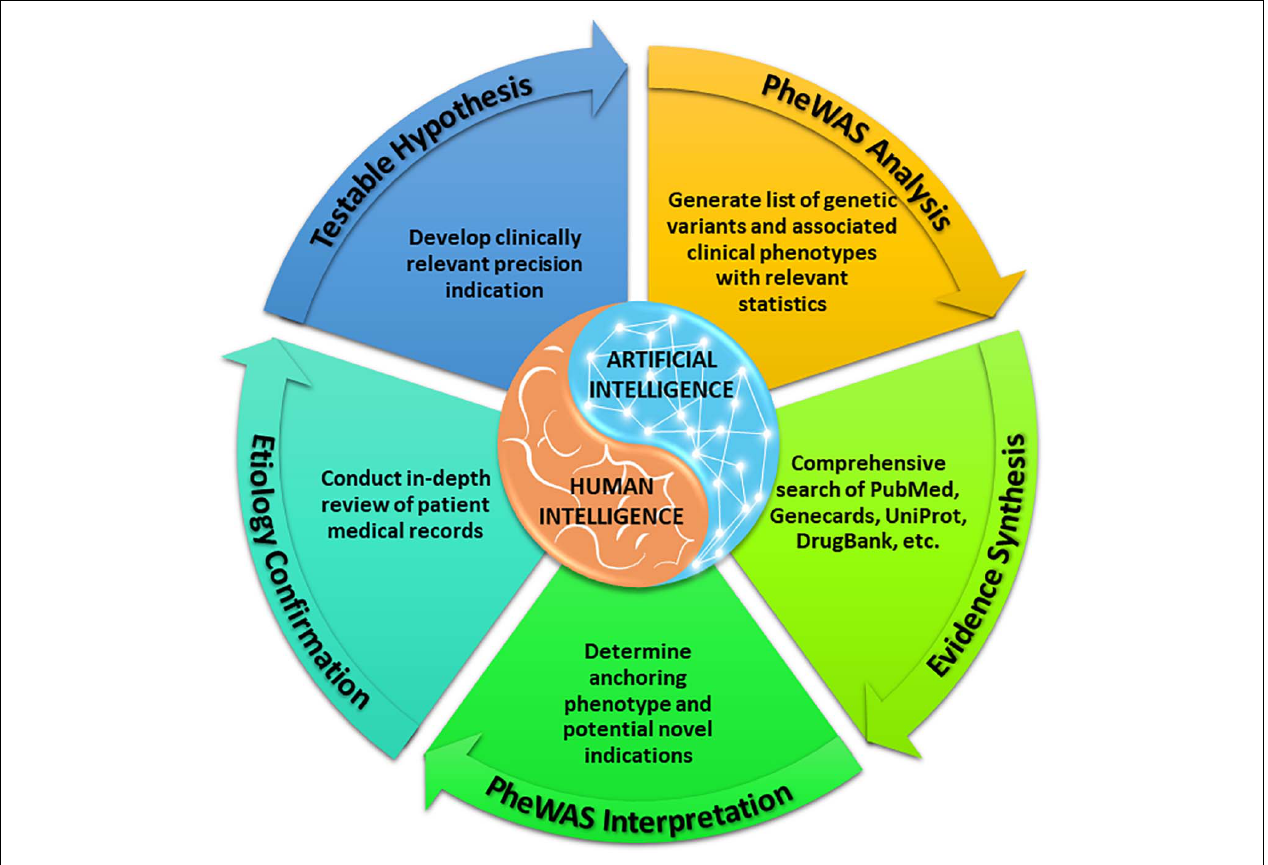
FIGURE 1 | VUMC Drug Repurposing Platform methods for establishing precision